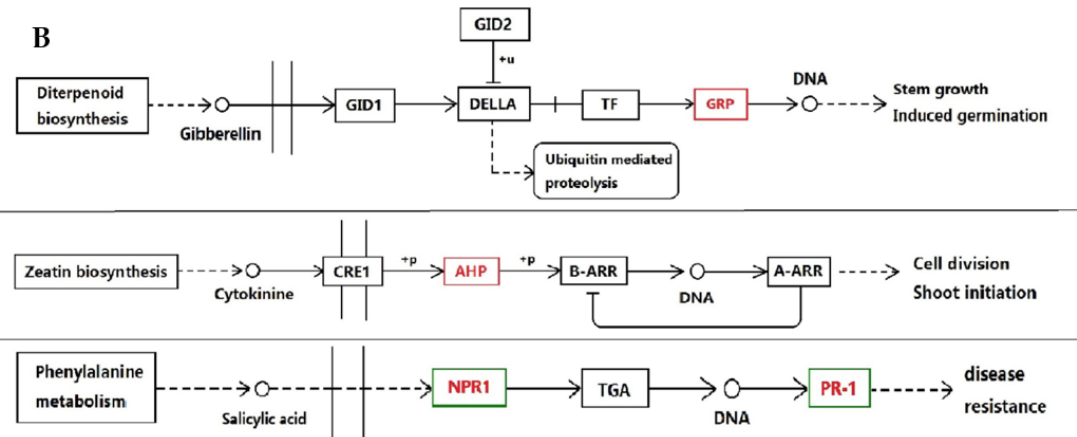
Figure 7. Maps of tryptophan metabolism and plant hormone signal transduction pathways: ( A ) tryptophan metabolism (auxin biosynthesis pathway); and ( B ) plant hormone signal transduction pathway. The red rectangles represent increased abundance proteins, and the green rectangles represent decreased abundance proteins. Definition of proteins indicated in Figure 7A: ALDH, aldehyde dehydrogenase family 2 member mitochondrial; KatE, catalase. Definition of proteins indicated in Figure 7B: GRP, gibberellin regulated protein; AHP, histidine-containing phosphotransfer protein; NPR1, regulatory protein NPR1; PR-1, pathogenesis-related protein 1. The dotted line means many steps of process; The double line means cytomembrane; +u means ubiquitination; +p means Phosphorylation; Vertical lines mean dissociation; The dotted line with a circle means chemical molecule undergoing several steps to combine with next substance.